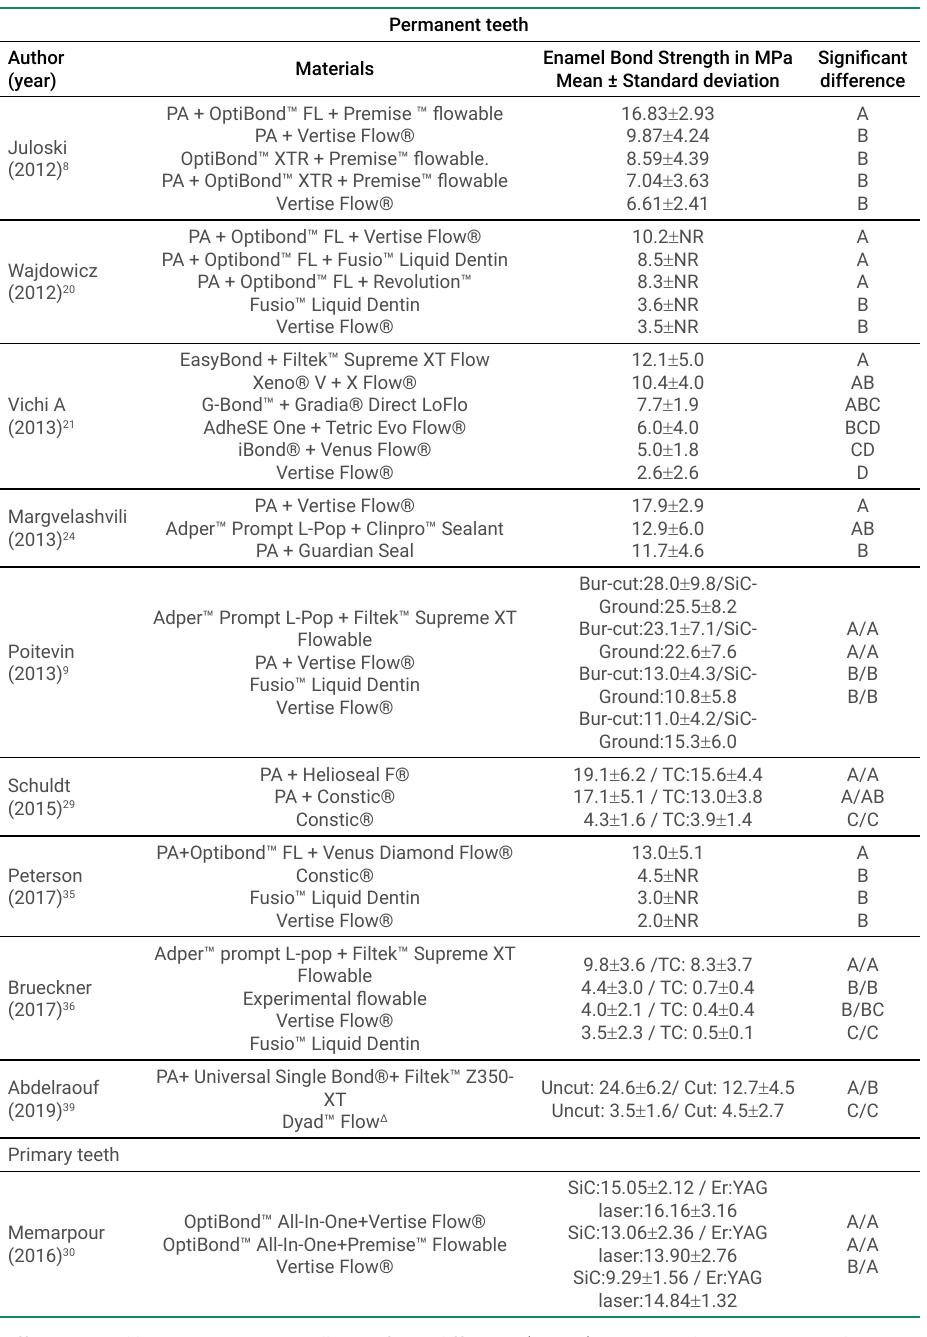
Table 3. Means, standard deviations and statistically significant differences on enamel bond strength between SAFRCs and CFRCs. Permanent